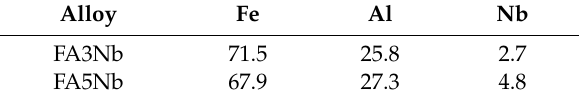
Table 1. Chemical composition of the studied alloys (at. %).